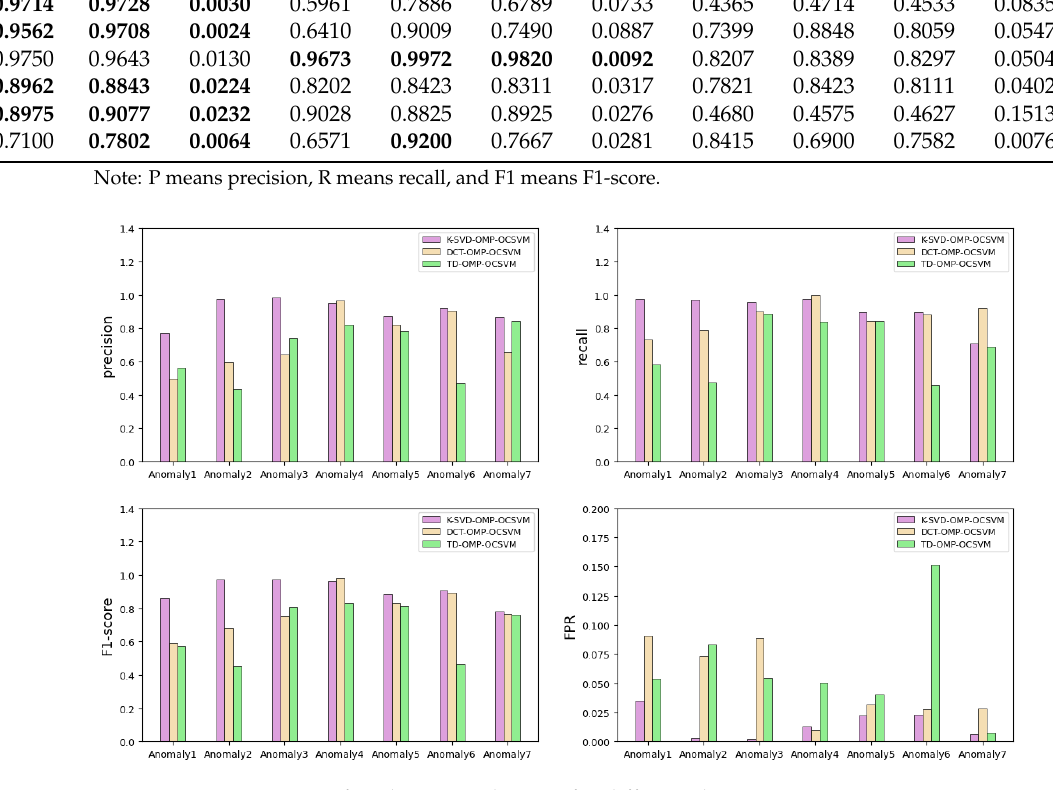
Figure 11. Comparison of evaluation indicators for different dictionaries in SFAD.